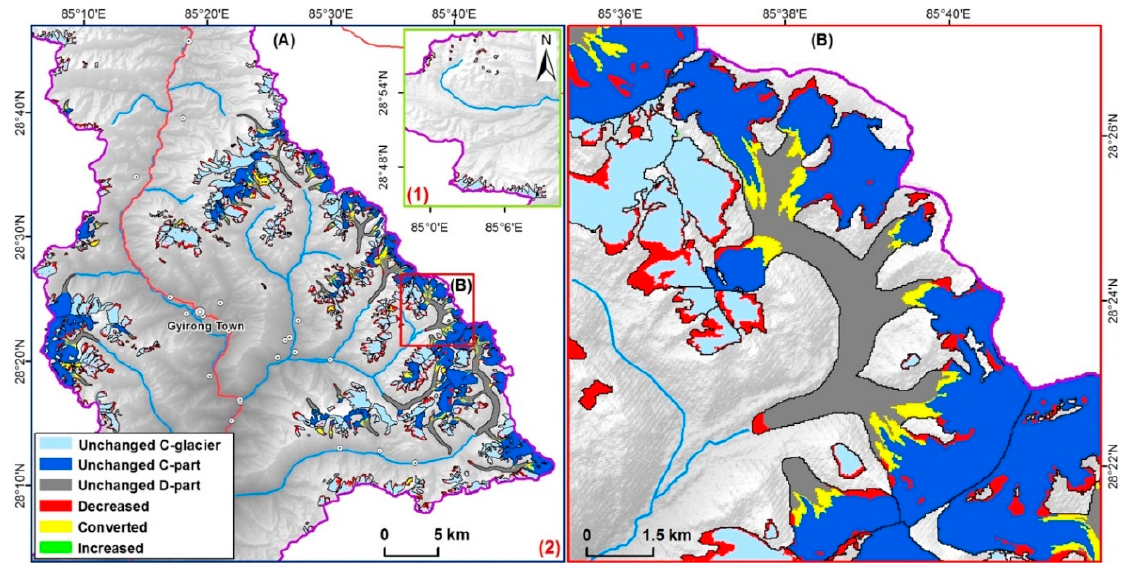
Figure 2. Spatial patterns of glacier changes between 1988 and 2015. Remote Sens. 2018 , 10 , x FOR PEER REVIEW Table 4. Summary of various scenarios of glacier changes between 1988 and 2015.